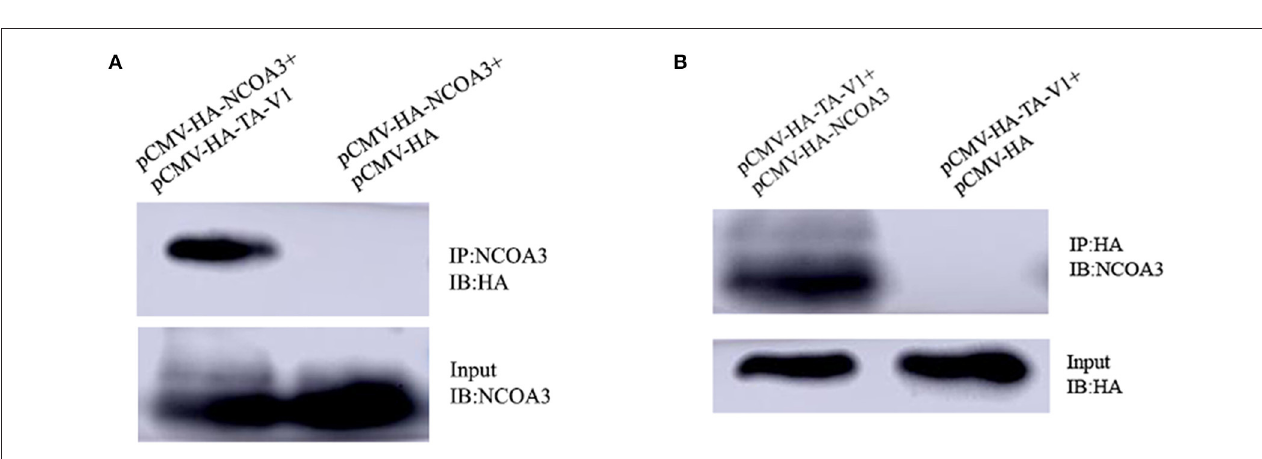
FIGURE 12 | Identification of the protein-protein interaction between TA-V1 and NCOA3 using Co-immunoprecipitation (Co-IP). HEK293T cells were transfected with pCMV-HA-TA-V1, pCMV-HA-NCOA3 or empty vector pCMV-HA. Cells were treated as described in Materials and Methods. (A) Anti-NCOA3 antibody was used as the primary antibody for Co-IP. (B) Anti-HA antibody was used as the primary antibody for